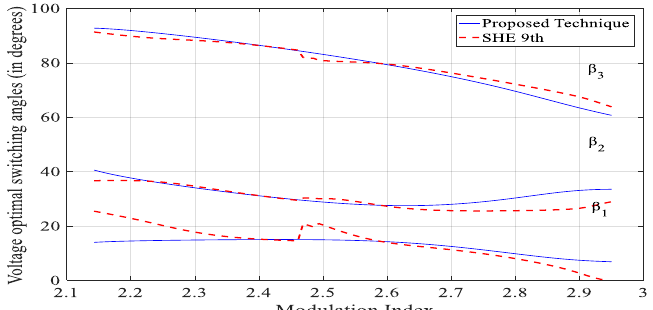
Figure 13. Curve showing variation between the estimated switching angles and modulation index for SHE of 9th-order harmonics and the proposed technique.